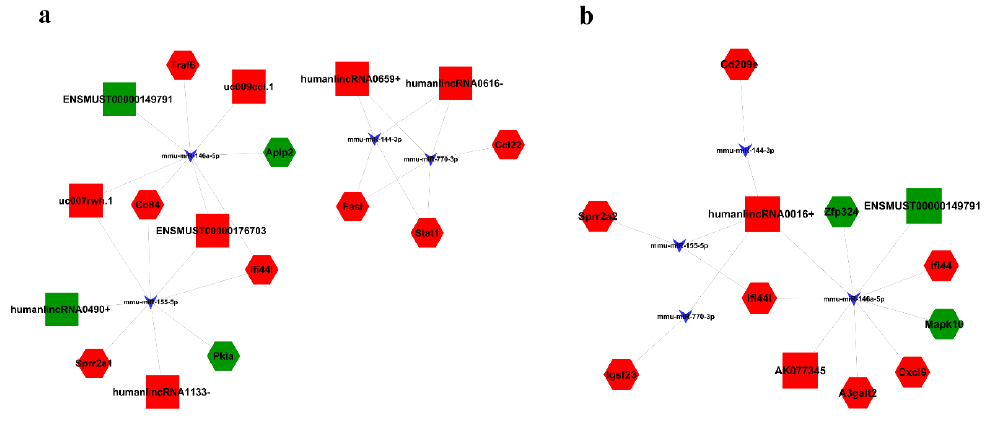
Figure 9. Competing endogenous RNA network in AD mice. miRNA-mediated lncRNA–mRNA ceRNA network. The competing endogenous RNA network is based on lncRNA/miRNA, lncRNA/mRNA, and miRNA/mRNA interactions. ( a ) The competing endogenous RNA network in the elicitation phase of AD. ( b ) The competing endogenous RNA network in remission of AD. (The triangles represent miRNAs, squares represent lncRNAs, and hexagons represent mRNAs. The red indicates an upregulation in the array data; the green indicates a downregulation in the array data.)